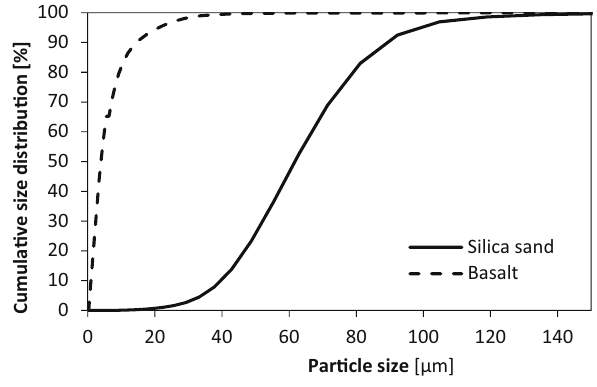
Figure 2: Distribution of fi nest particles, obtained by laser